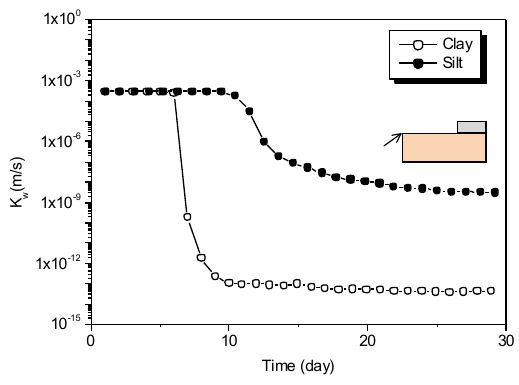
Figure 13b. Variation of the soil permeability in point A Fig. 13b. Variation of the soil permeability in point A.